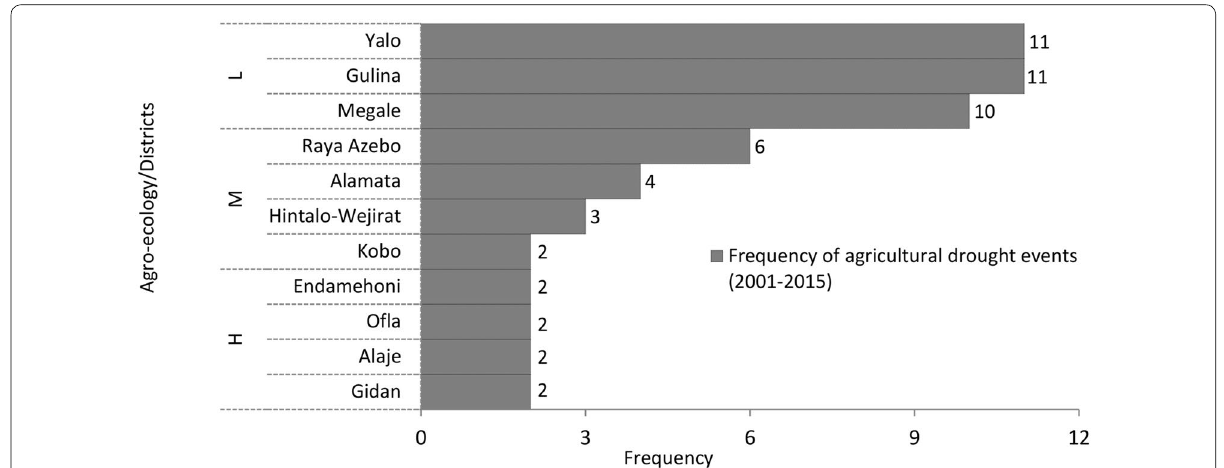
Fig. 6 Agro-ecological based frequency of agricultural drought incidence from 2001 to 2015. L lowlands, M midlands, H